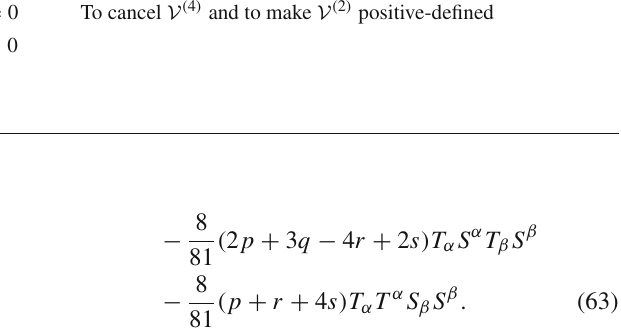
Table 1 Conditions over the free parameters of the Lagrangian density (24) for stability and reduction to GR when the torsion vanishes T μ S μ Description Ghost-free p − r + 2 s = 0 q = 0 To remove the scalar/pseudo-scalar mode and to ensure a well-posed kinetic term p + s + t < 0 2 r + t < 0 Tachyon-free (Weak torsion) c + 3 λ > 0 b + 3 λ > 0 To have a positive-defined quadratic potential V ( 2 ) Tachyon-free (General